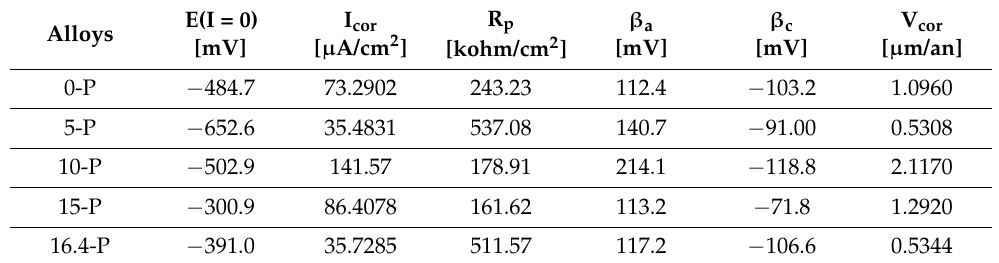
Table 4. Values of E, I cor , β a , β b , V cor .